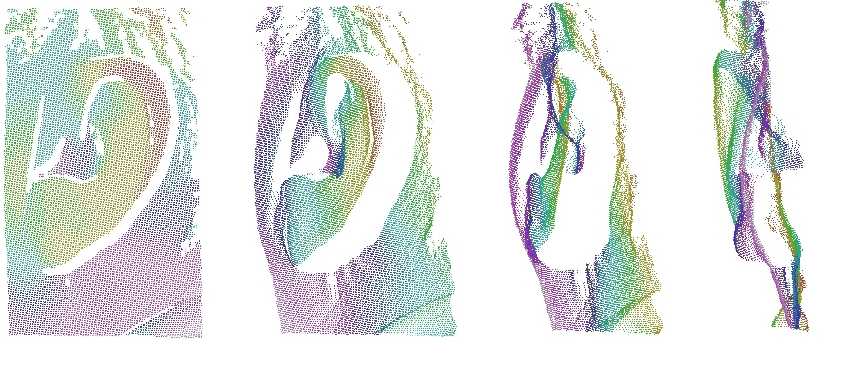
Fig. 6 Laser surface scan of the auricle, displayed from various views.